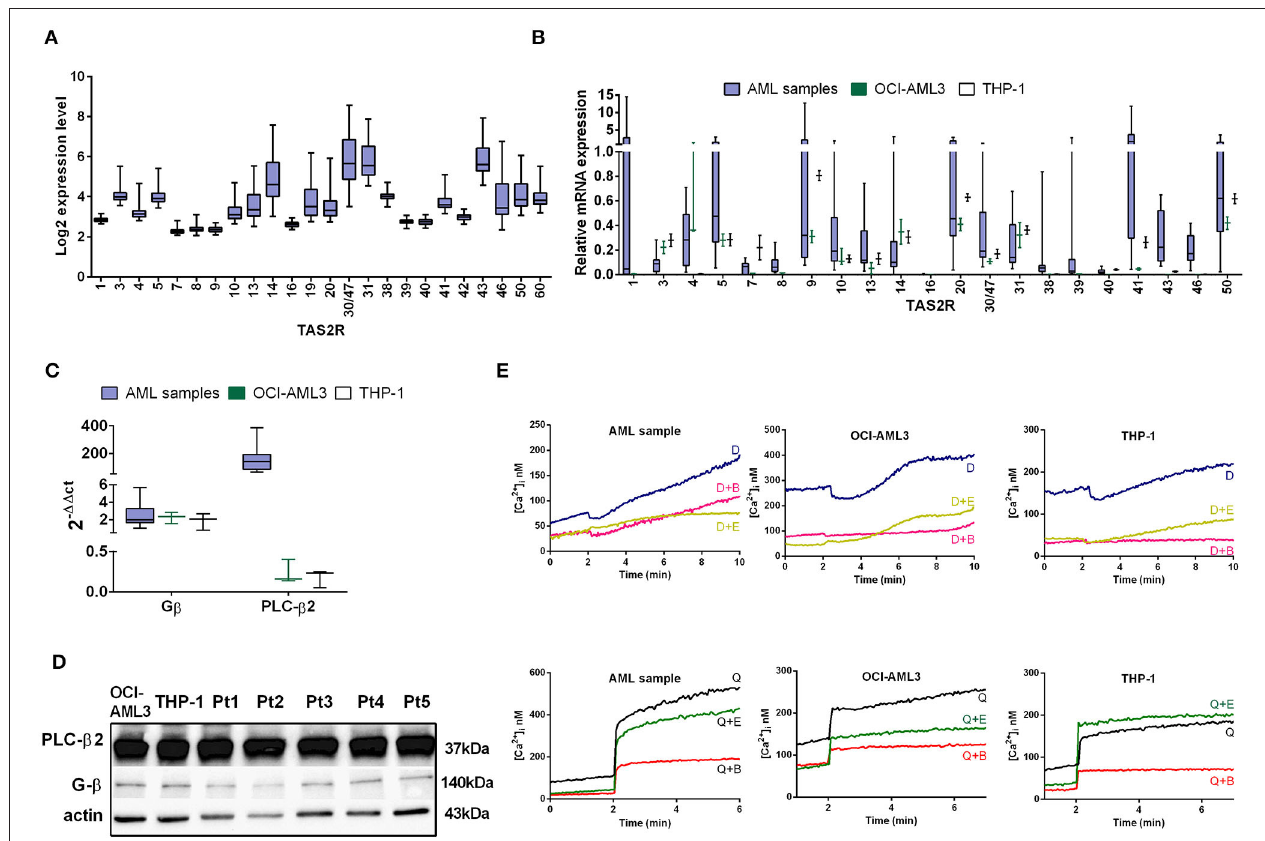
FIGURE 1 | TAS2R expression in AML. (A) Box plots illustrate relative TAS2R mRNA expression obtained by GEP in primary AML samples ( n = 61). (B) Box plot illustrate TAS2R mRNA expression analysis by qRT-PCR in primary AML samples ( n = 13) and AML cell lines, THP-1 and OCI-AML3. Error bars refer to THP-1 and OCI-AML3 sample triplicates. Relative TAS2R expression levels were calculated using GAPDH as endogenous control and commercial cDNA pool as the reference sample was taken as 1 (2 − 11 Ct method). Melt curve analysis confirmed the presence of a single PCR product and Ct values of expressed targets ranged between 25 and 30. (C) qRT-PCR analysis of TAS2R downstream targets in primary AML samples and AML cell lines. Relative target expression levels were calculated as described in (A) . Error bars in AML columns refer to the 13 analyzed samples. THP-1 and OCI-AML3 samples were analyzed in triplicates. (D) Western blot analysis of the downstream targets in two AML cell lines and five AML samples (Pt). Actin was shown as the loading control. (E) Ca 2 + release in a representative AML sample and AML cell lines loaded with the Ca 2 + indicator fura-2/AM and treated with 10mM denatonium (indicated as D) or 75 µ M quinine (indicated as Q) in presence of EDTA (indicated as E) or BAPTA-AM (indicated as B)